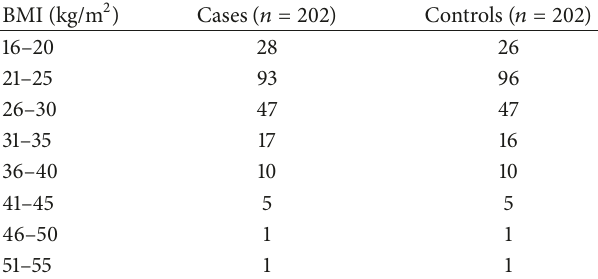
Table 2: Distribution of body mass index across cases and controls. BMI (kg/m 2 )